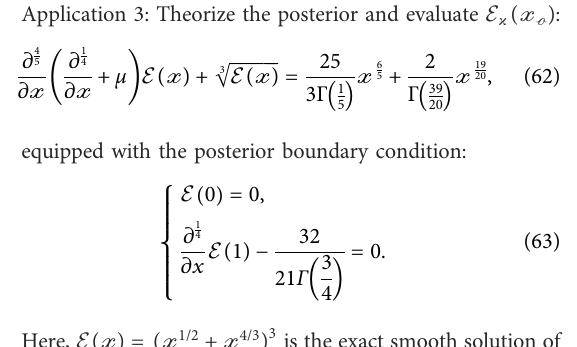
Algorithm 2. Gram – Schmidt process.